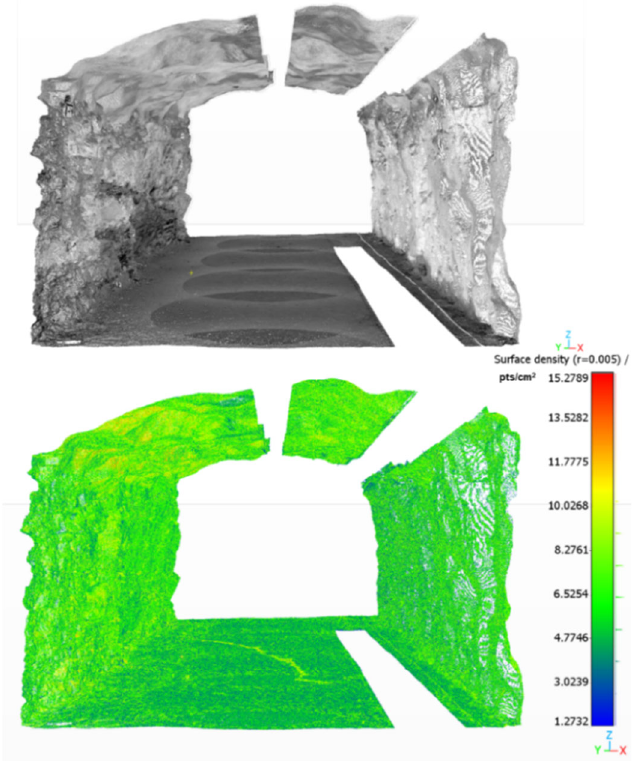
Figure 10. Reference point cloud of the tunnel section ( above ) with a uniform point density ( below ), obtained with the Riegl VZ ‐ 400i terrestrial laser scanner (TLS).